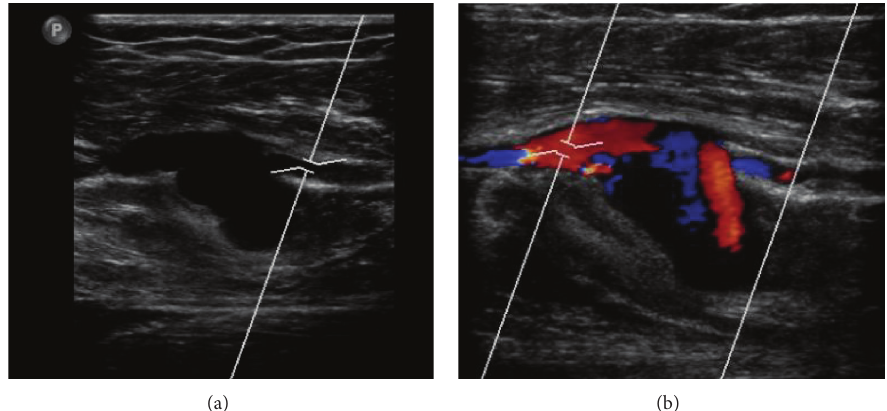
Figure 4: Ultrasound (a) Gray-scale and (b) Color Doppler images show the peroneal artery and veins directly entering the pseudoaneurysm sac. Swirling of blood flow on Color Doppler results in the characteristic “Yin-Yang” appearance.